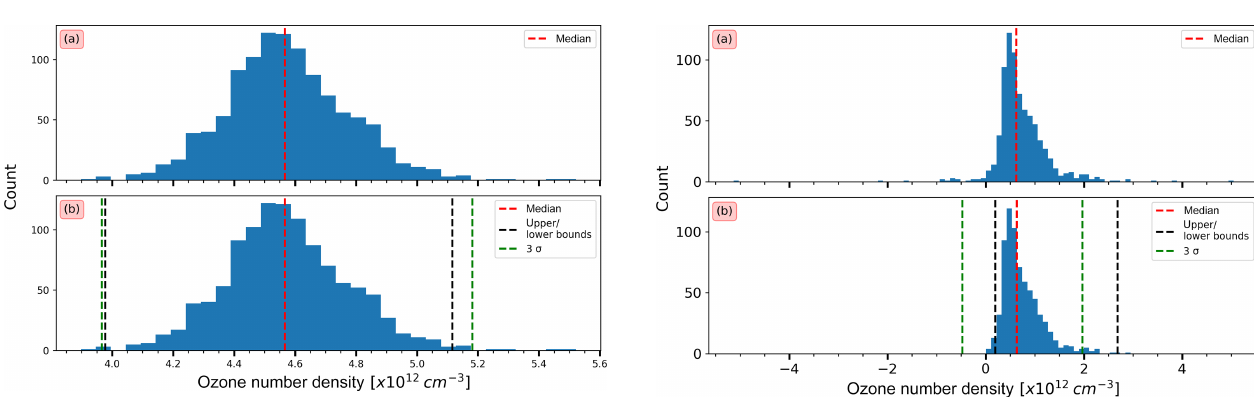
Figure 11. As in Fig. 10 but for ozone data at 18km between 15 and 25 ◦ N for January.